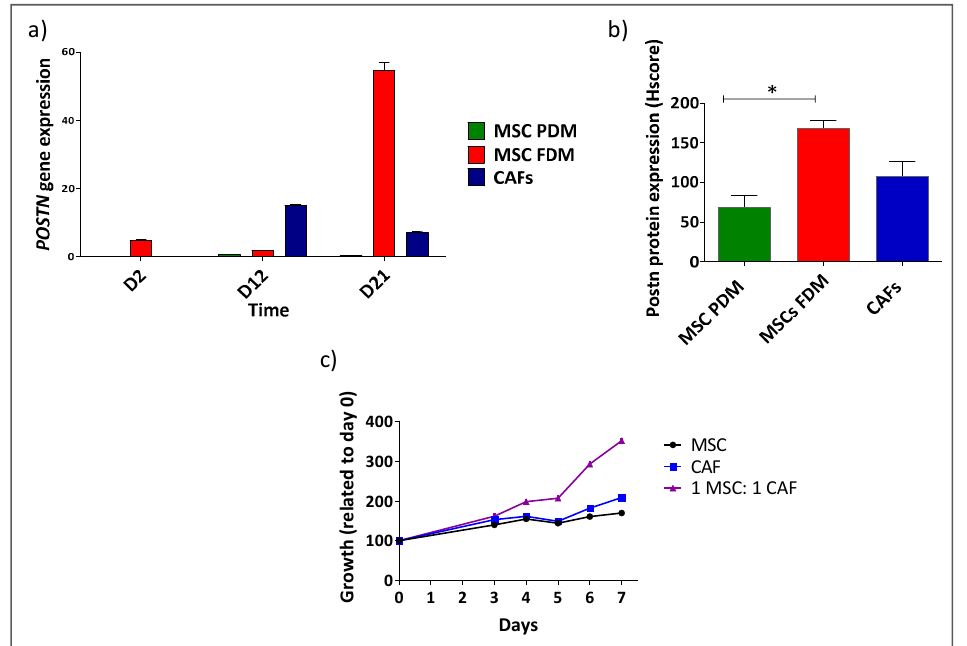
Figure 3. In vitro models comprising mixed populations of α SMA + and α SMA − cells show interaction between the two component cell lines. Postn expression in MSCs grown in FDM at the gene ( a ) and protein level (* p < 0.05 one-way ANOVA multiple comparison test) ( b ) in comparison to MSCs grown in PDM or CAFs. ( c ) Growth of α SMA − (MSCs in PDM) and α SMA + (CAFs) mixed at a 1:1 ratio or each population alone in a 3D assay.